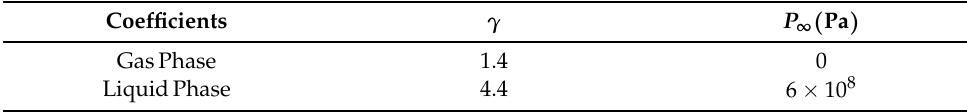
Table 2. Stiffened-Gas coefficients for air and liquid water